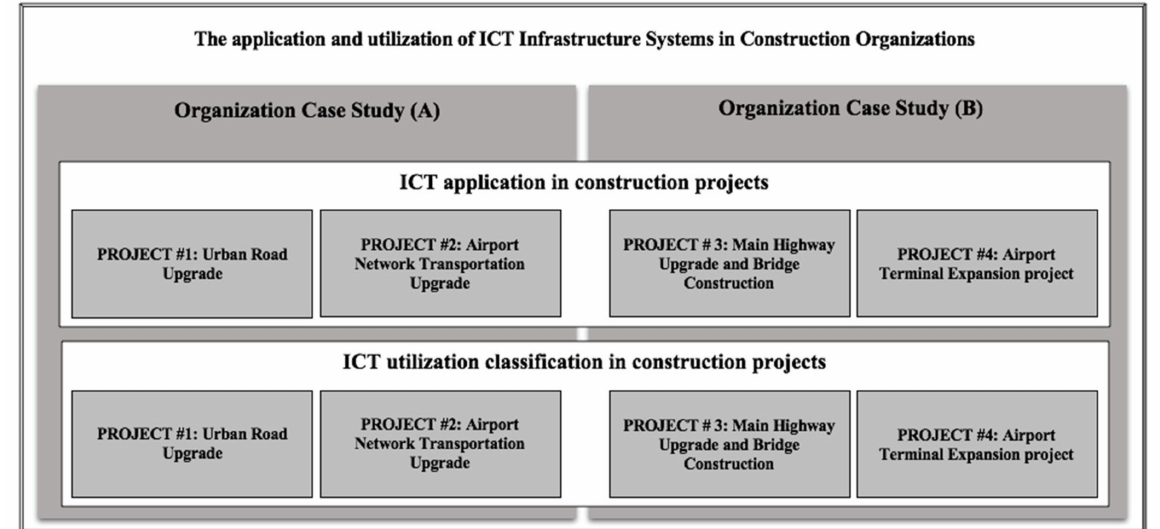
Figure 2. The case study methodology